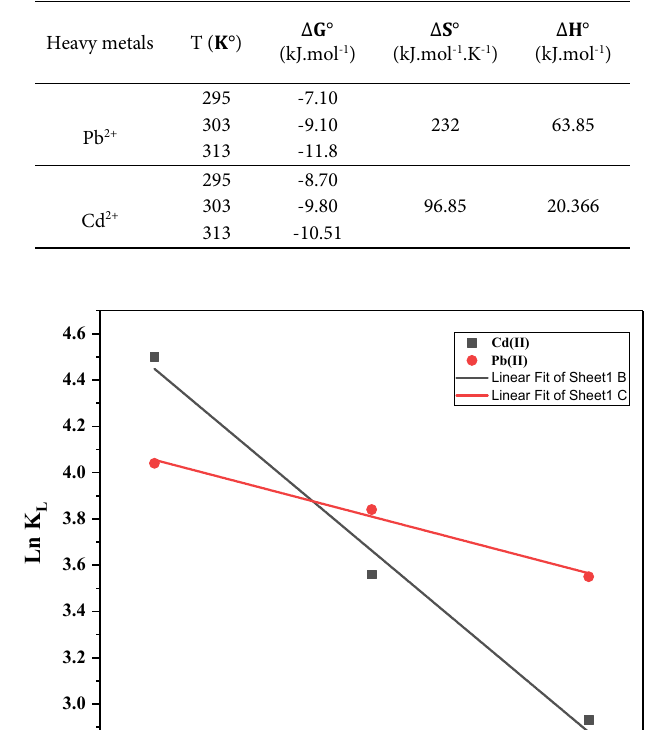
Table 4. Thermodynamic parameters for Cd(II) and Pb(II) adsorption by pectin/ γ -Fe